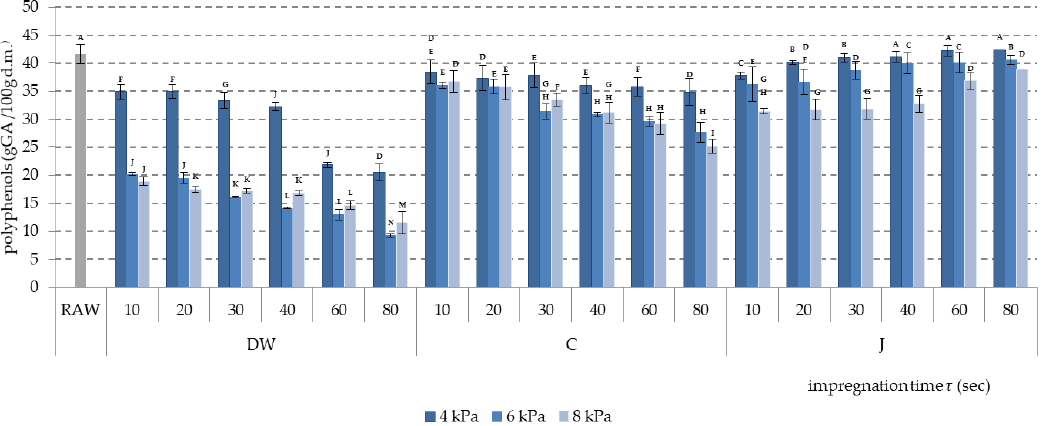
Figure 4. Polyphenol content during vacuum impregnation of apples conducted using apple-pear juice (J), citric acid solution (C), and distilled water (DW) as impregnating liquids. Values followed by different letters (A, B, C…) were significantly different ( p < 0.05) according to Tukey’s test.